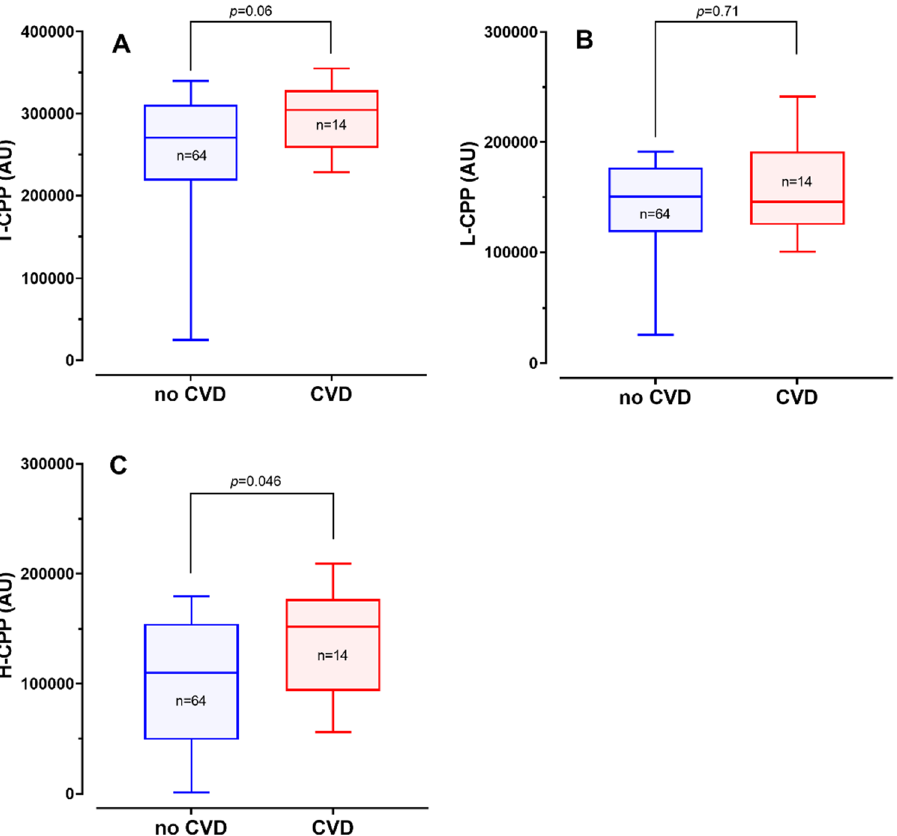
Figure 2. Comparison of CPP levels between patients with and without cardiovascular disease (CVD) . Box plots showing plasma levels of T-CPP ( A ), L-CPP ( B ), and H-CPP ( C ) in patients with CVD (CVD) and without CVD (no CVD). The number of patients (n) and p values by Wilcoxon test are indicated.